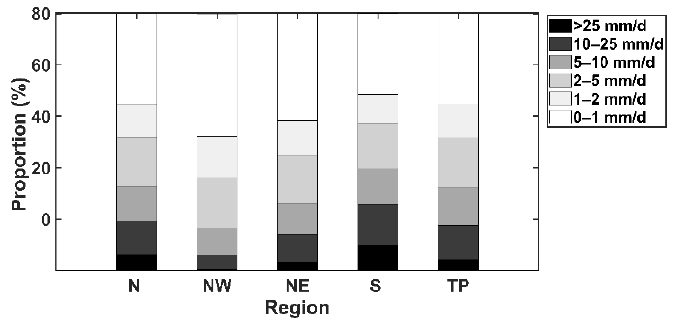
Figure 7. The relative frequency of precipitation days for different types of precipitation in the classified five regions of Northeast China (NE), Northwest China (NW), South China (S), North China (N), and Tibetan Plateau (TI).